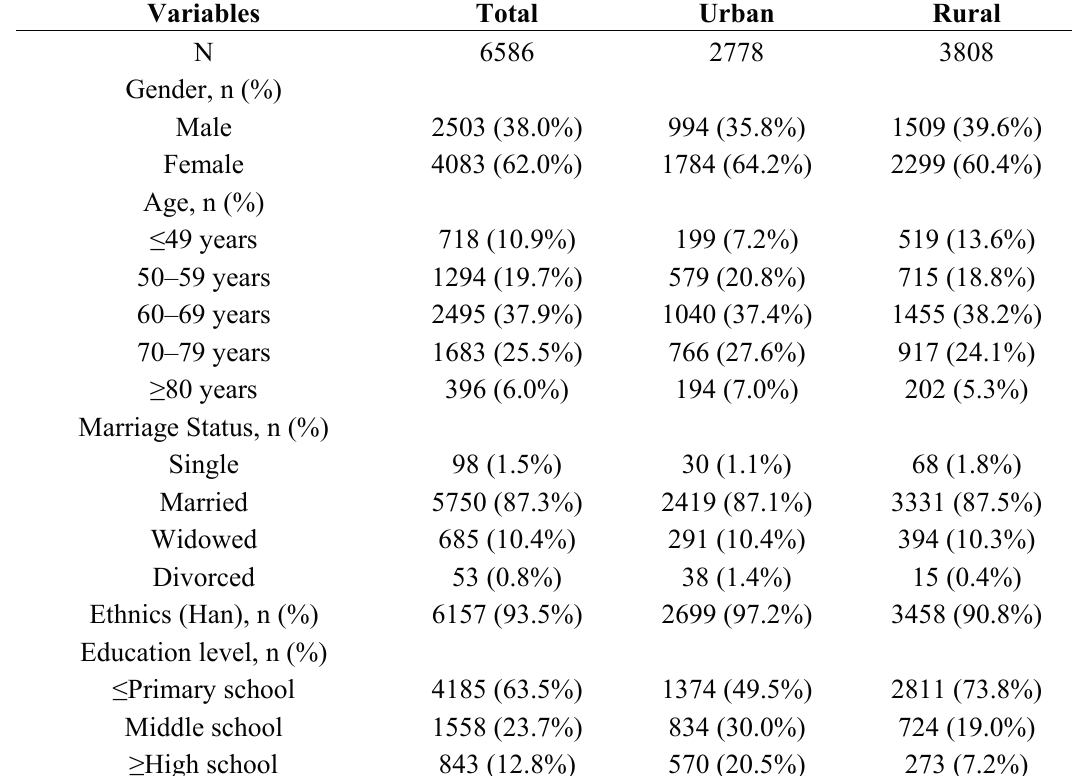
Table 2. Characteristics of participants in our